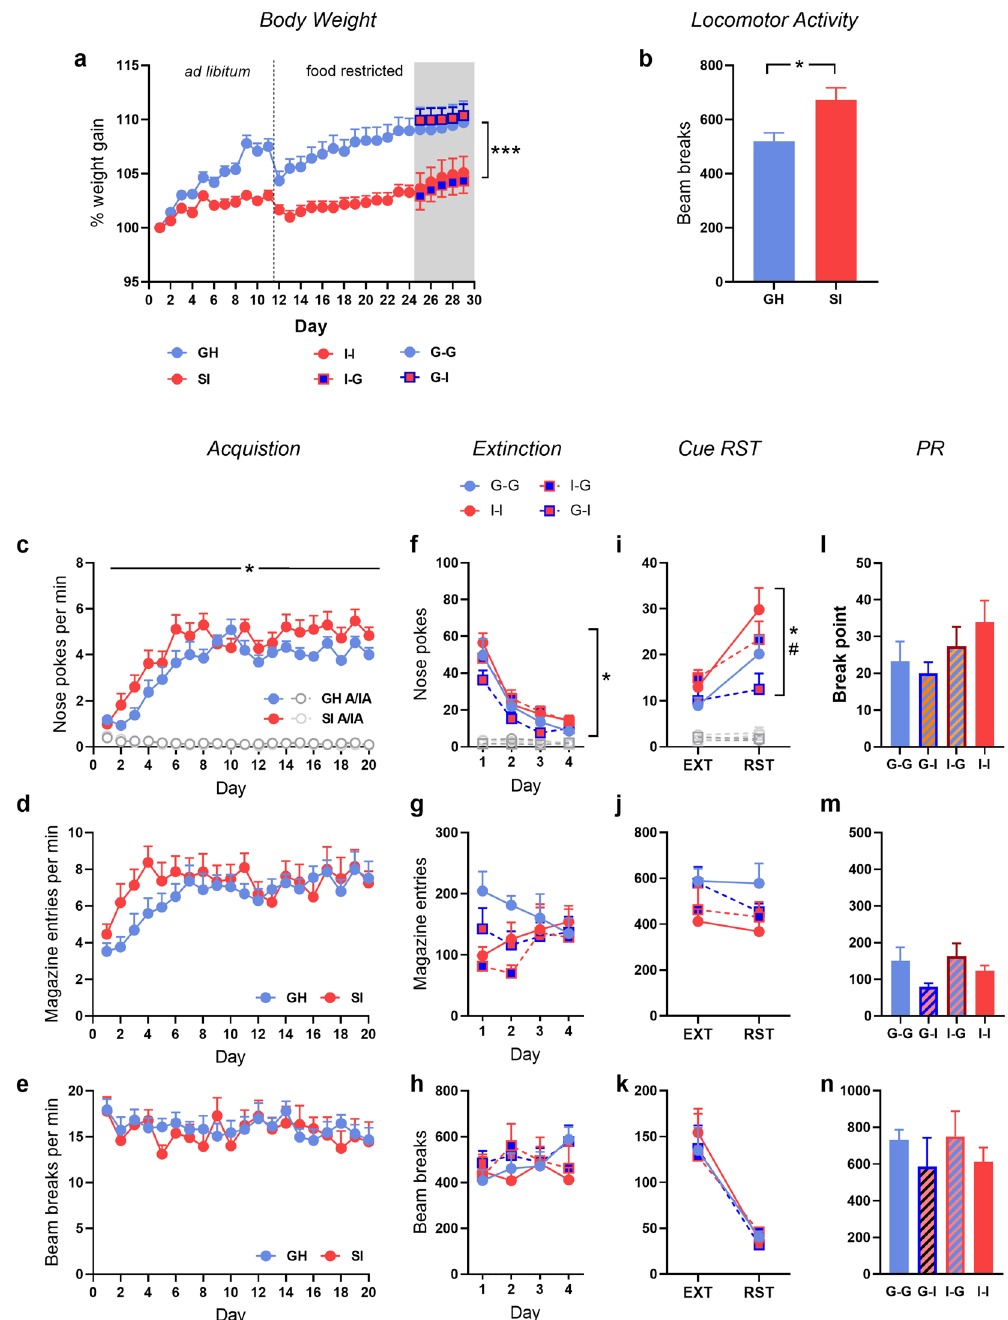
Figure 4. Experiment 3: The effect of reversing housing condition on acquisition versus reinstatement of responding for a sucrose pellet. ( a ) Percentage weight gain across the entire study, including when food was freely available (ad libitum), when food was restricted prior to operant training (food restricted) and with a change in housing condition (grey area). ( b ) Spontaneous locomotor activity during habituation to the instrumental chambers. Active (colour) and inactive (grey) nose-pokes, magazine entries and locomotor activity across acquisition ( c–e ), extinction training ( f–h ), cue-reinstatement ( i – k ), and the progressive ratio (PR) test of motivation for the food reward ( l–n ). GH group housed, SI socially isolated. GH/G–G group housed, SI/I–I socially isolated, G–I initially group housed, isolated after acquisition, I–G initially socially isolated, returned to group housing after acquisition. Symbols indicate effect or interaction including initial housing (*) or housing following the switch (#) where p < 0.05. n =